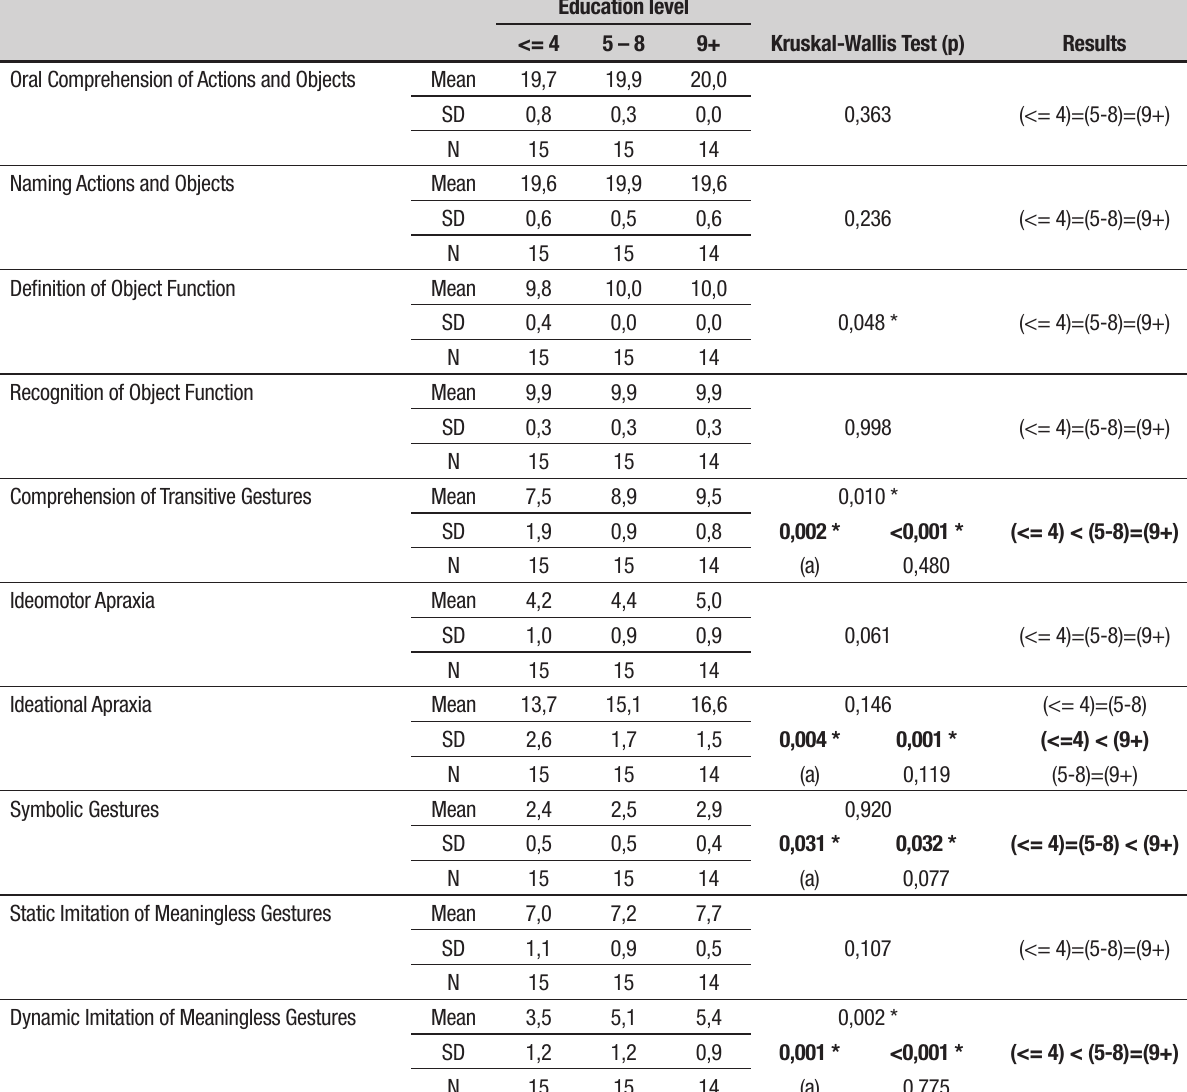
Table 1. Performance of healthy subjects for each of the subtests in the limb apraxia battery, considering education level and Kruskal-Wallis